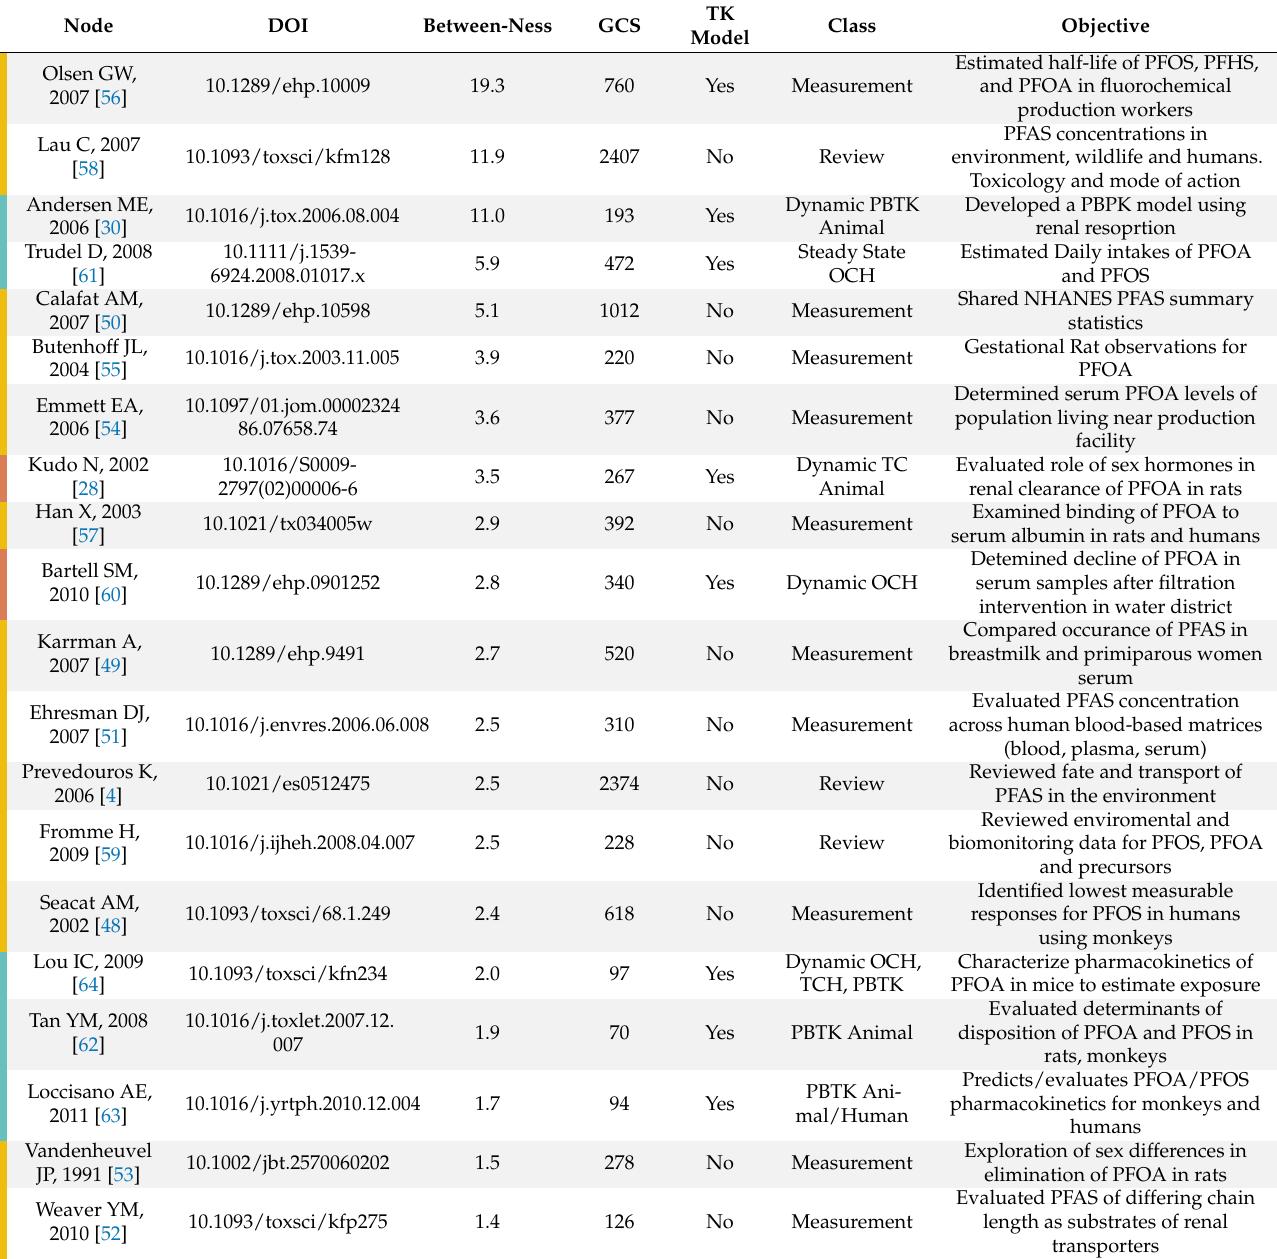
Table 2. Louvain betweenness of nodes in co-citation